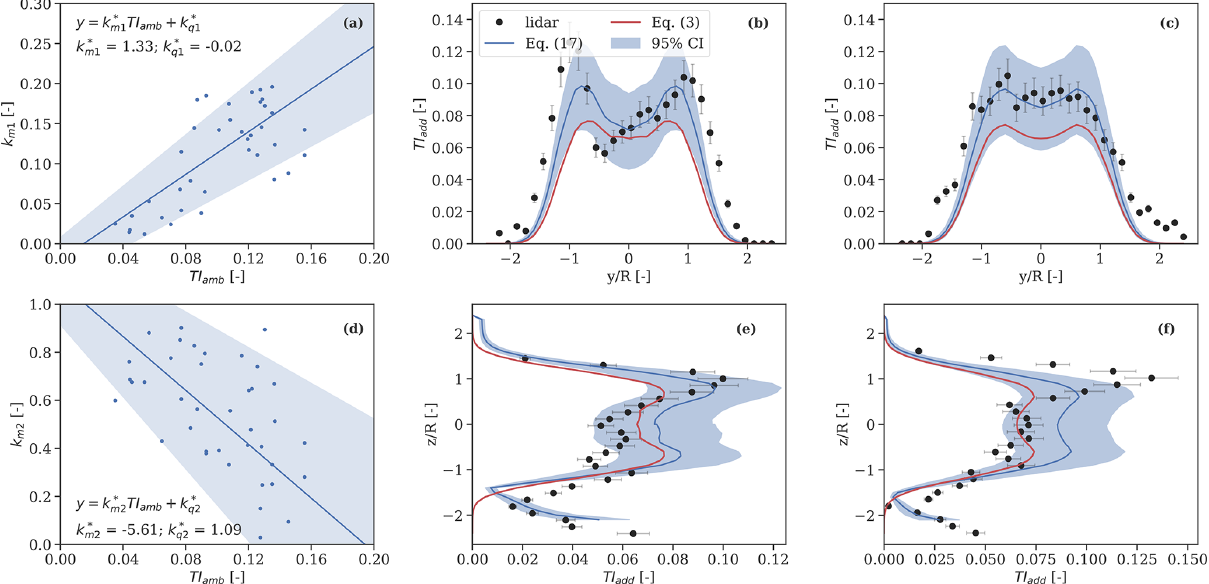
Figure 11. Wake-added turbulence predictions. Panels (a) and (d) show the relation of both k m1 and k m2 in Eq. (3) to the ambient turbulence. The linear regression model that is determined using Bayesian inference is shown by solid lines, whereas the shaded areas indicate the 95% confidence interval obtained by propagating the posterior PDFs of the parameters. The comparison between measured (markers) and predicted (lines) lateral wake-added turbulence profiles resolved in the MFoR at hub height and obtained at 2.5 D behind the rotor is shown in (b) and (c) for TI amb = 7% and 12%, respectively, whereas the relative vertical profiles are shown in (e) and (f) . The error bars indicate the measurement uncertainty, whereas the shaded areas indicate that of the model predictions relative to the 95% confidence interval. The predictions from Eq. (3) are computed using the mean values of k m1 = 0 . 11 and k m2 = 0 . 54, which are obtained from all the observations in (a) and (d)